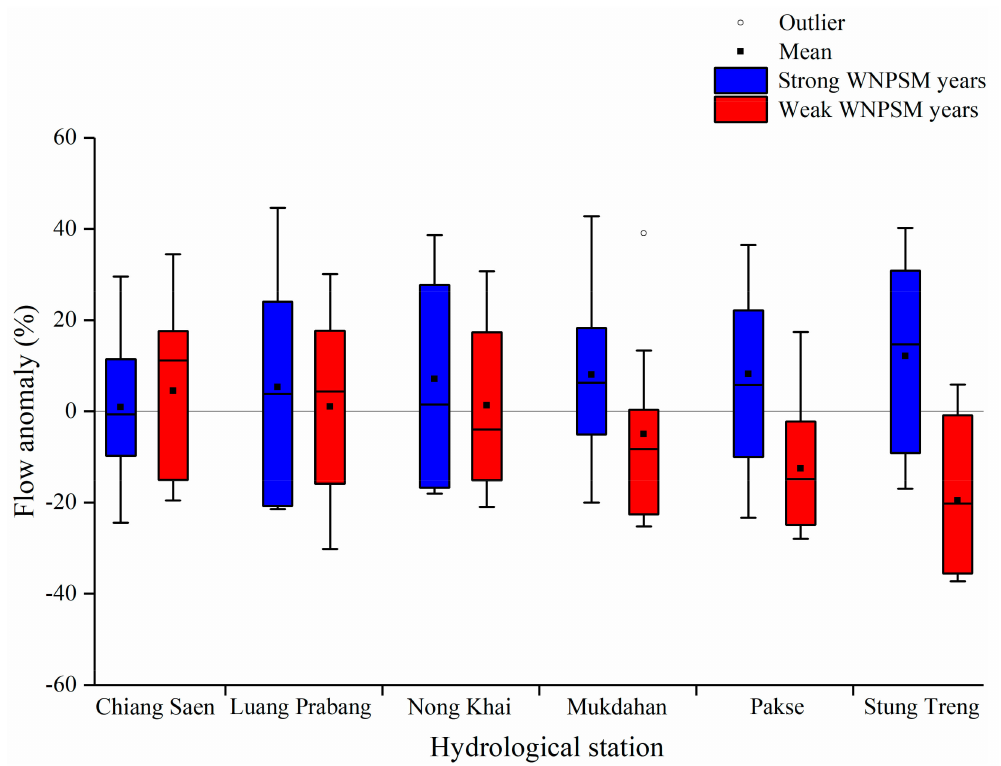
Figure 10. Flow anomalies during JJAS associated with WNPSM at six hydrological stations. Time series at Chiang Saen, Luang Prabang and Nong Khai stations are 1970–2012, and those at Mukdahan, Pakse and Stung Treng stations are